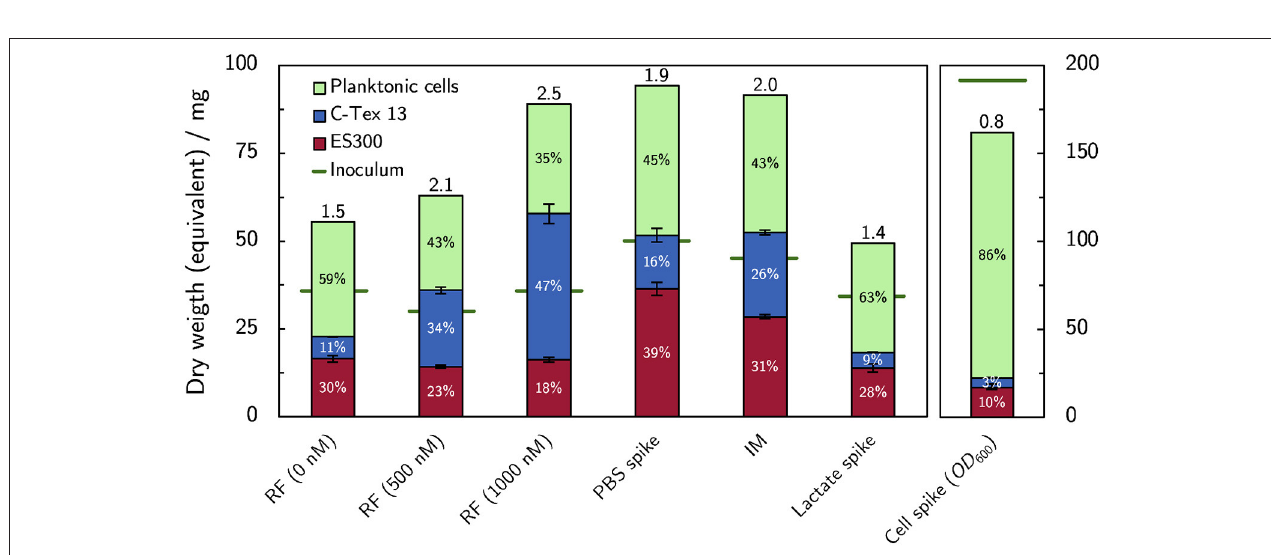
FIGURE 6 | Dry weight equivalents of the biofilm on the anodes and planktonic cells. Addition of flavin enhances biofilm formation on C-Tex 13. PBS addition improves mainly the biofilm formation on ES300. The numbers at the column tops indicate the total growth yield in the reactor (total dry weight equivalent at the end of the experiment divided by the dry weight equivalent of the inoculum). Note the different scale of the inoculation experiment, depicted on the right. The dry weight of the biofilms attached to the anodes ( n = 3) and the dry weight equivalent of planktonic cells were evaluated at the end of the experiment on day 6 (supplemented RF, IM) or 10 (spike experiments). The numerical values can be found in Supplementary Table 4